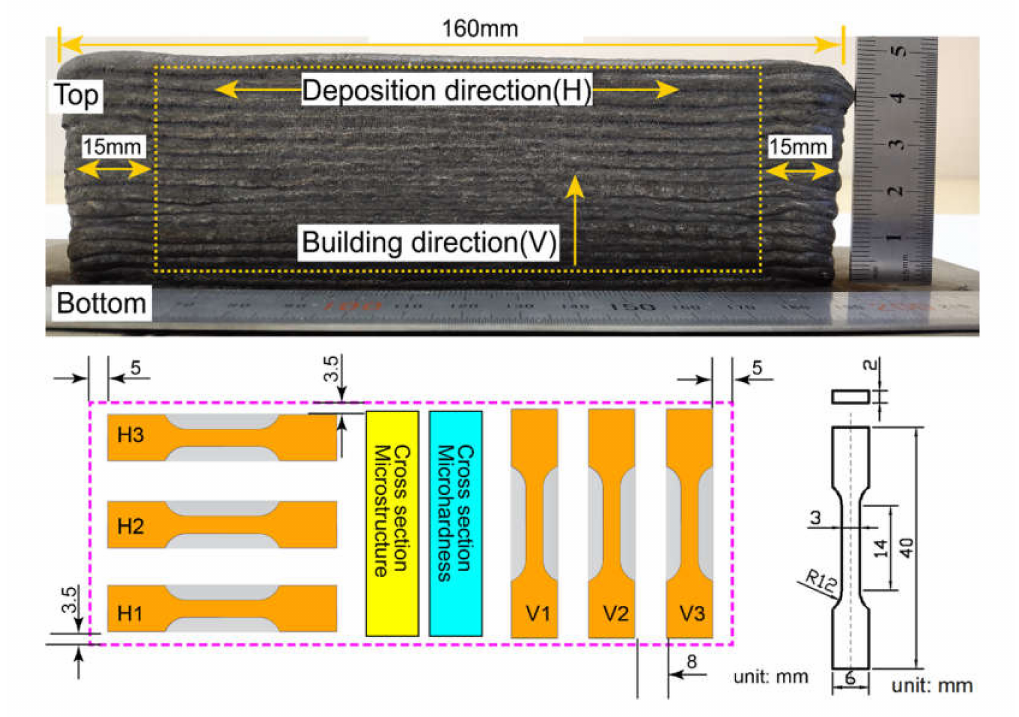
Figure 2. Schematic diagram of sampling location and the size of the tensile